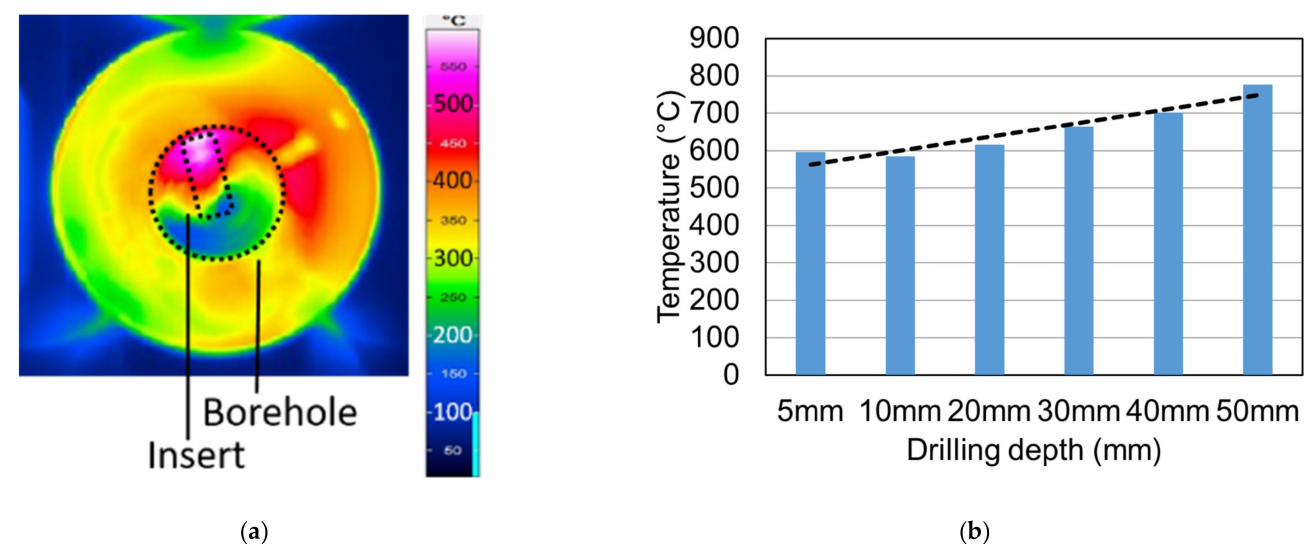
Figure 3. Thermography image of the backside of the workpiece at the moment of breakthrough ( a ) and maximum temperature at the cutting edge measured in the experiment ( b ) [10].